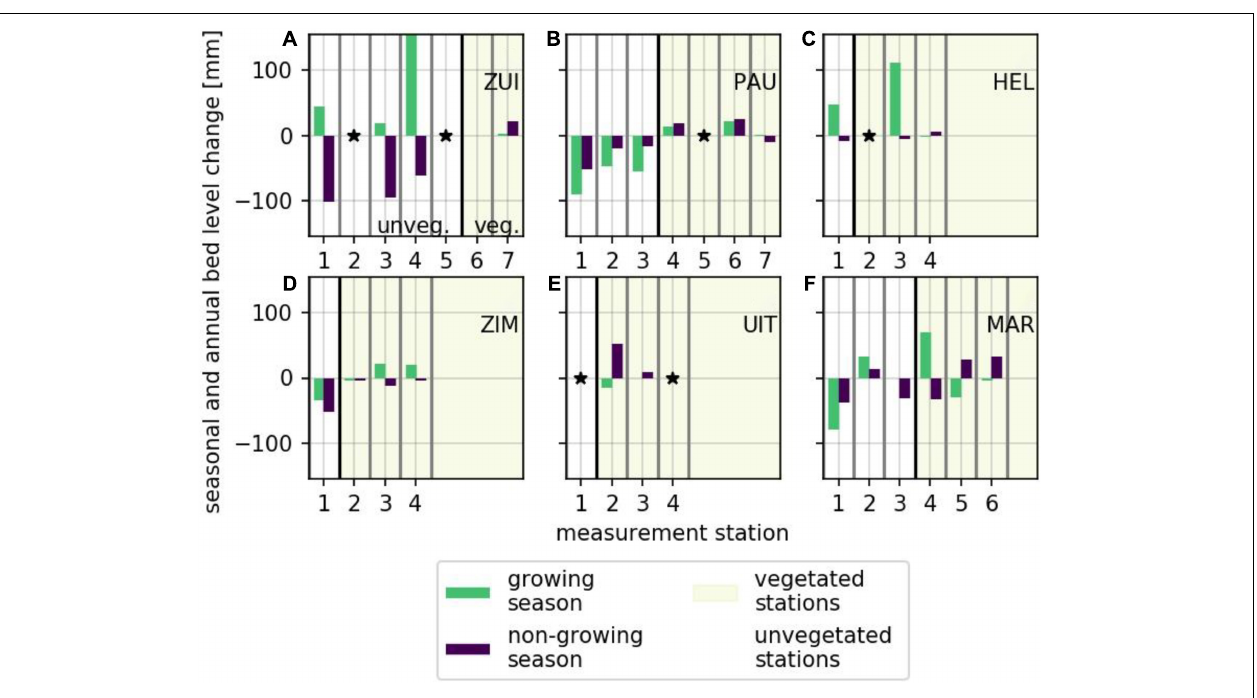
FIGURE 10 | Rates of bed level change during growing (green) and non-growing season (purple) at vegetated (no shading) and unvegetated (shading) measurement stations (separated by a thick black line). (A) Zuidgors. (B) Paulina. (C) Hellegat. (D) Zimmerman. (E) Uithuizen. (F) Marconi. Asterisks indicate insufficient data as explained in section “Data